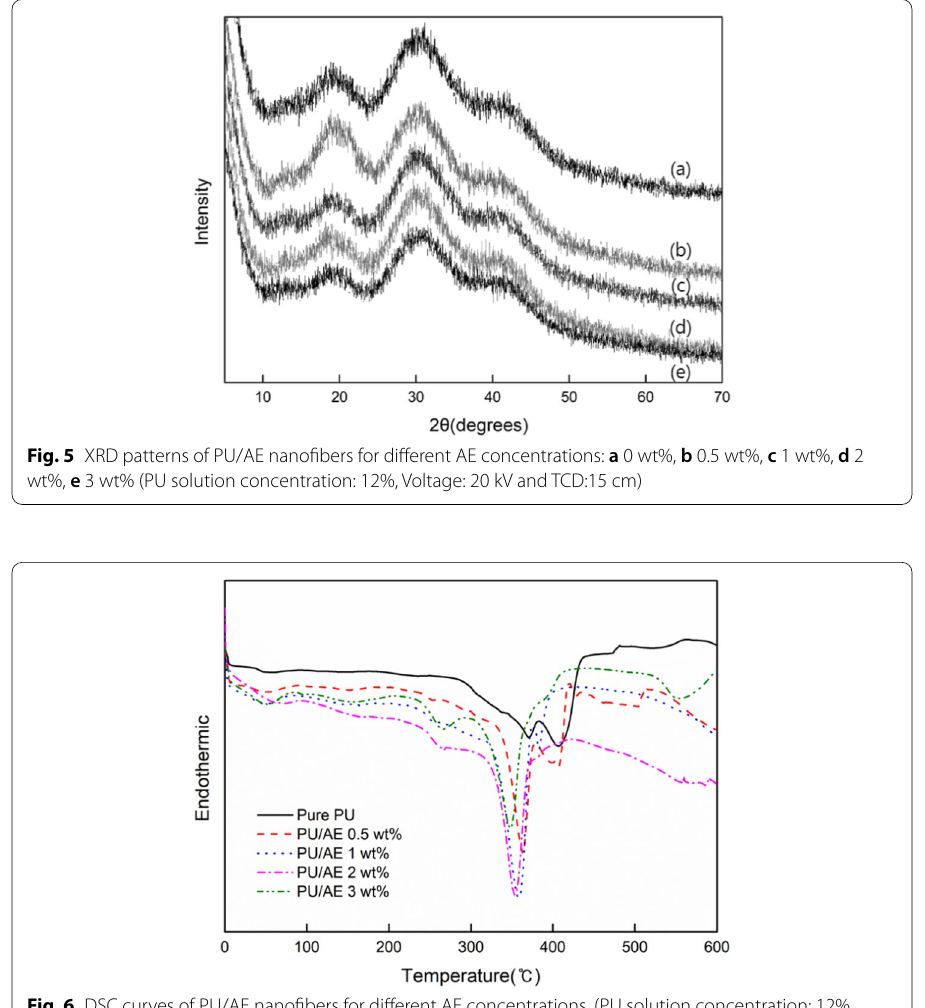
Fig. 6 DSC curves of PU/AE nanofibers for different AE concentrations. (PU solution concentration: 12%, Voltage: 20 kV and TCD:15